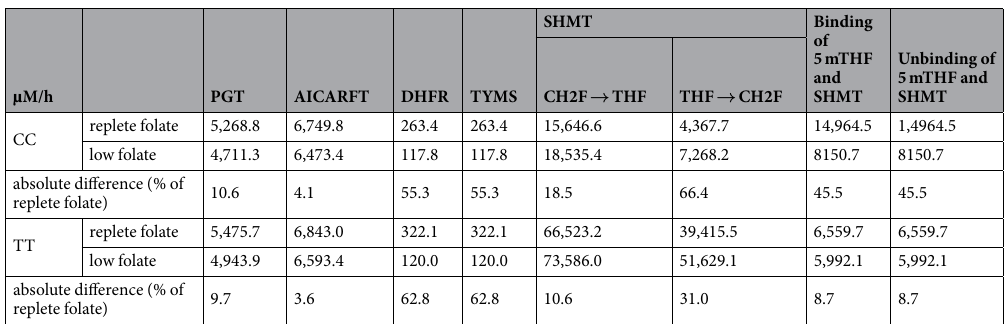
Table 9. Fluxes of the reactions catalyzed by the enzymes PGT, AICARFT, DHFR, TYMS and SHMT and the binding/unbinding of 5 mTHF and SHMT for replete (18 µ M) and low (9 µ M) levels of total folate and for the CC and TT case of the C677T MTHFR polymorphism.